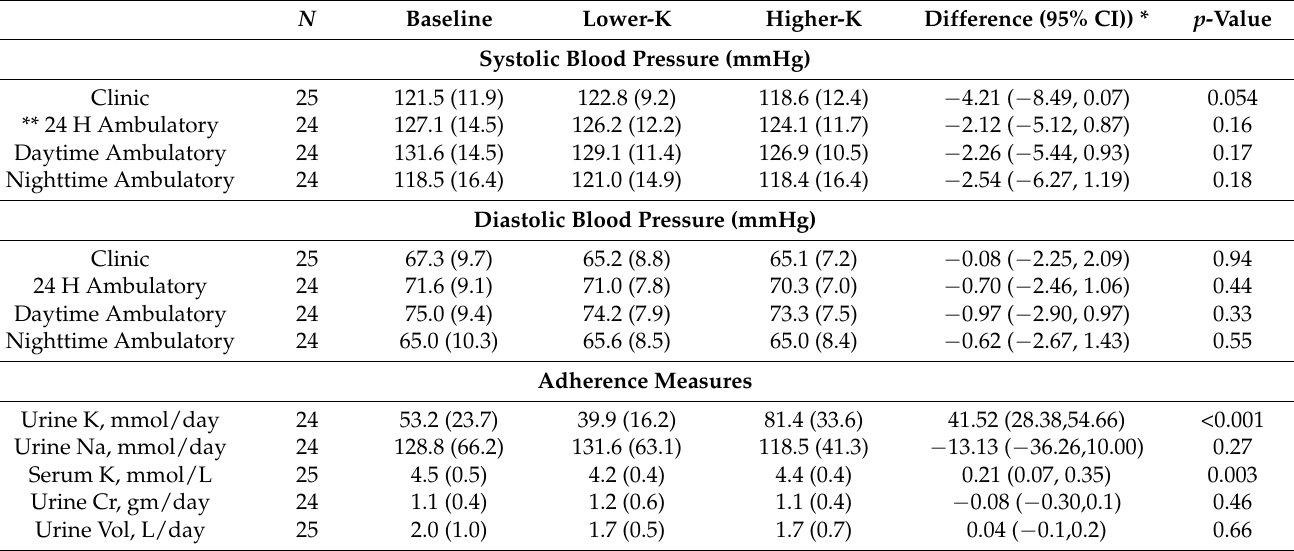
Table 3. Effects of Higher- versus Lower- K Diet on Blood Pressure and Urine Electrolytes.